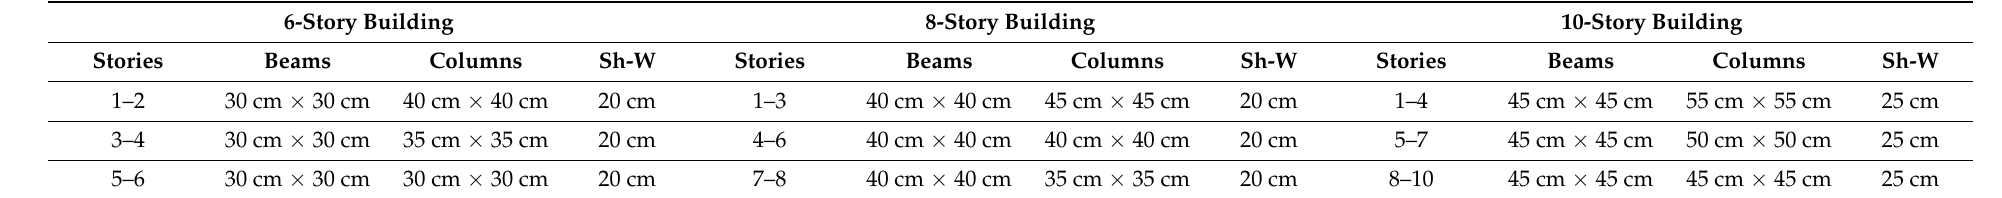
Table 1. Section details of the six-, eight-, and 10-story